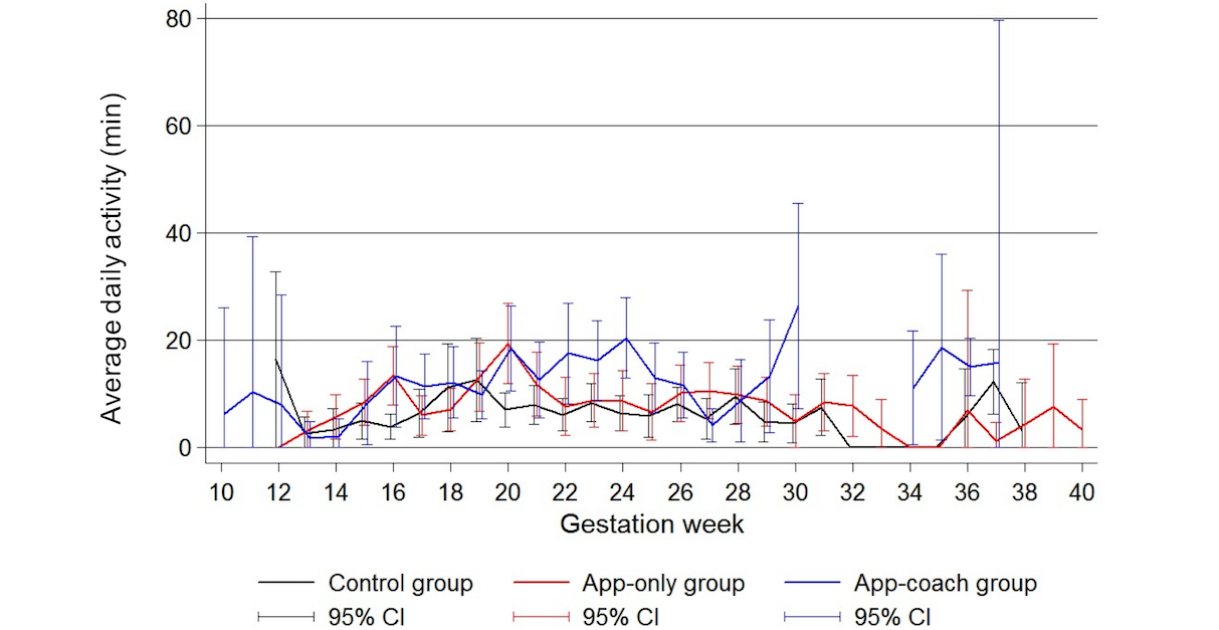
Figure 2. Line plot showing the average (mean and 95% CI) daily activity in minutes by gestation week and treatment group for the 27 patients who completed the study. Note missing activity data in the app-coach group between 30 and 34 weeks.